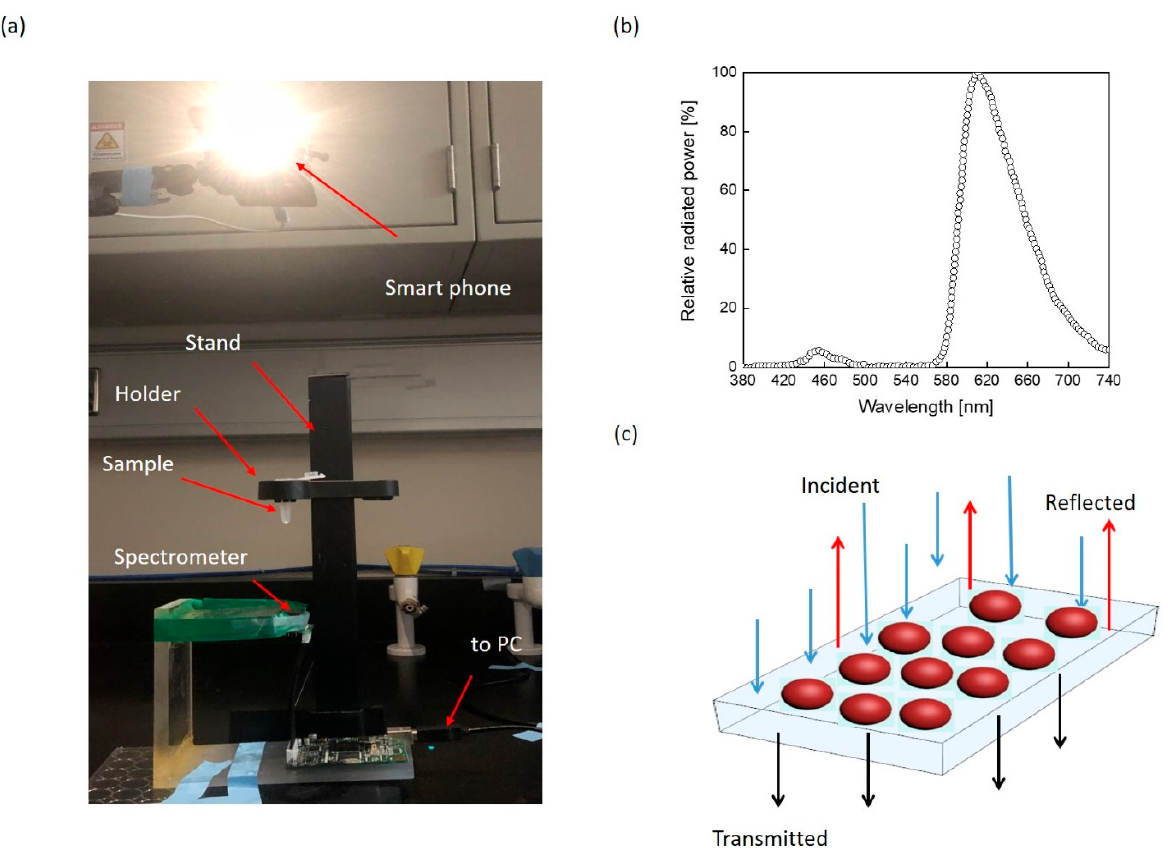
Figure 2. The proposed concept of optical detection and the experimental design: ( a ) the optical measurement setup is shown, consisting of a smart phone as a light source and the mini-spectrometer utilized to collect the light waves passing through the sample kept in the holder. ( b ) The smart phone power spectra vs. wavelength. ( c ) Illustration of the spectrometer detection principle.